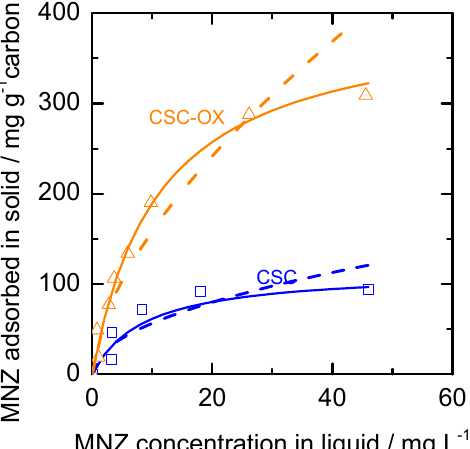
Figure 6. Adsorption isotherm of metronidazole on CSC and CSC-OX (data: square and triangle; Langmuir-fitted curve—full line; Freundlich-fitted curve—dash line).